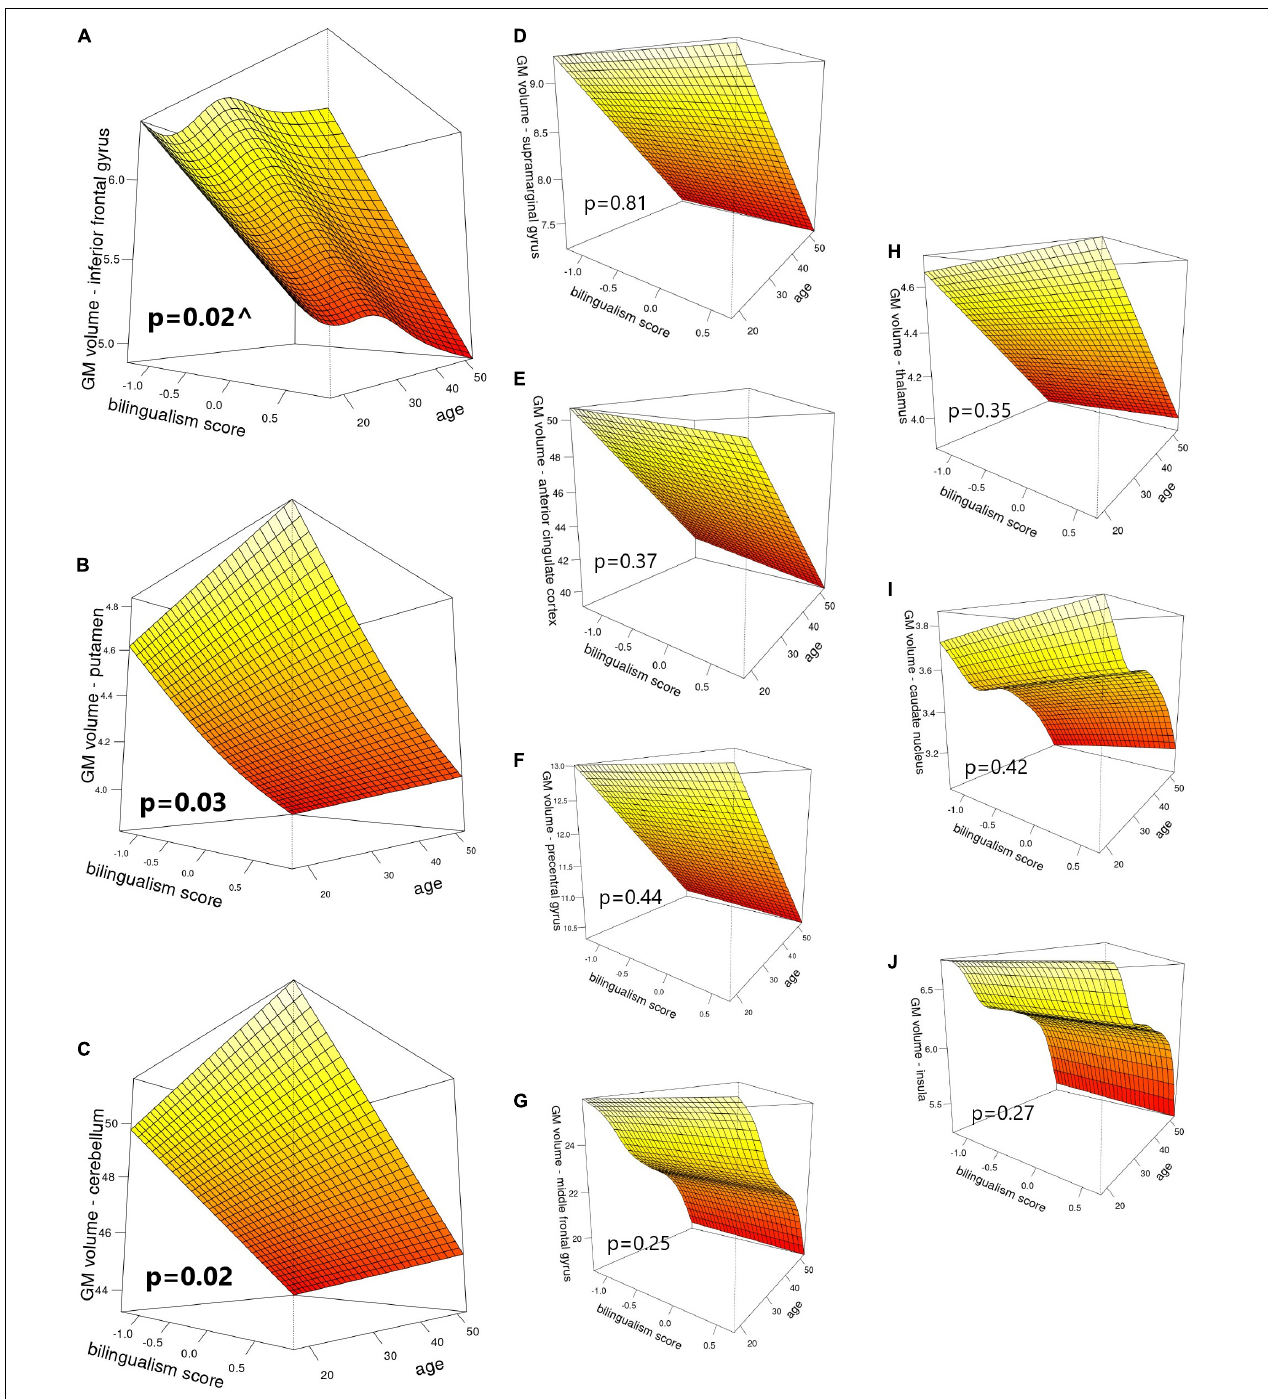
FIGURE 1 | Visual representation of bilingualism score and age as predictors of GM volumes (cm 3 ) in: (A) inferior frontal gyrus, (B) putamen, (C) cerebellum, (D) supramarginal gyrus, (E) anterior cingulate cortex, (F) precentral gyrus, (G) middle frontal gyrus, (H) thalamus, (I) caudate nucleus, and (J) insula. P -values correspond to the main effect of bilingualism score. ˆ indicates edf > 1, denoting a non-linear effect.